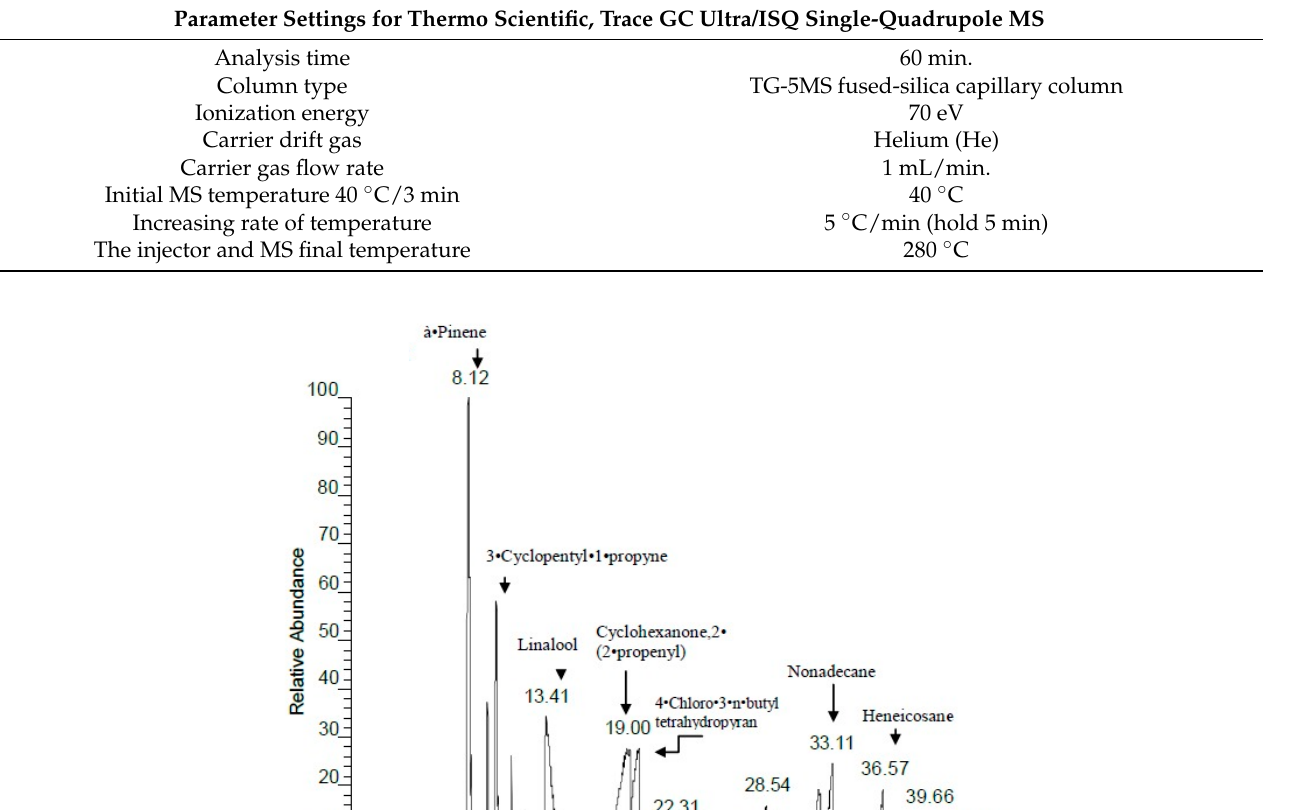
Table 1. Various parameters of GC–MS analysis used in this research.